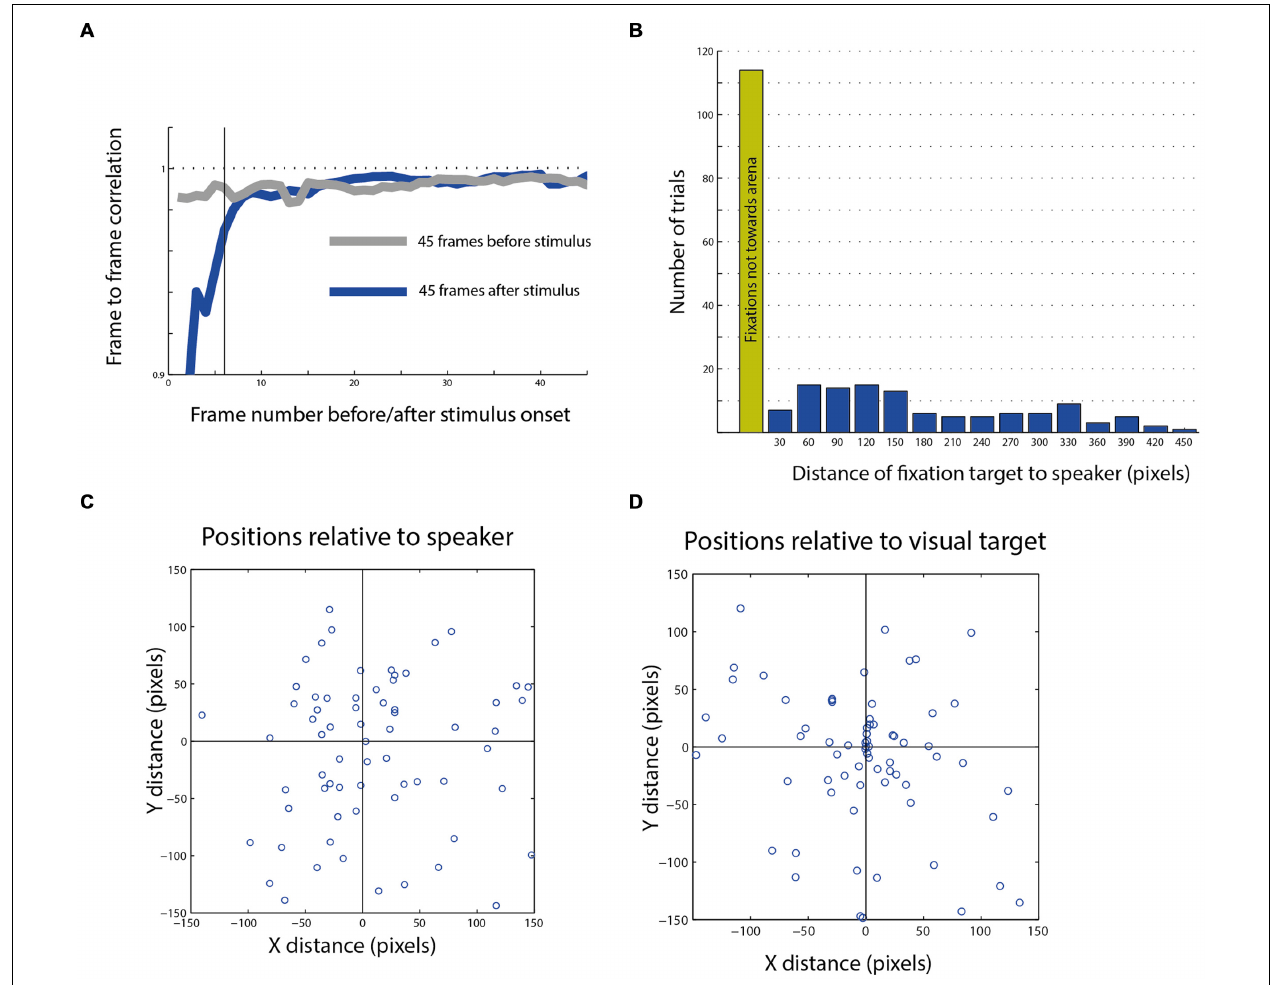
fixation points from speaker location of all movements toward the arena (blue columns).The green column shows the number of fixation points that landed outside of the arena. (C) A scatterplot showing the population of fixation end-points which landed in the general area of the speaker plotted with relation to the speaker location (0,0 point). (D) The same population as in (C) , plotted with relation to the visual target closest to the speaker (0,0